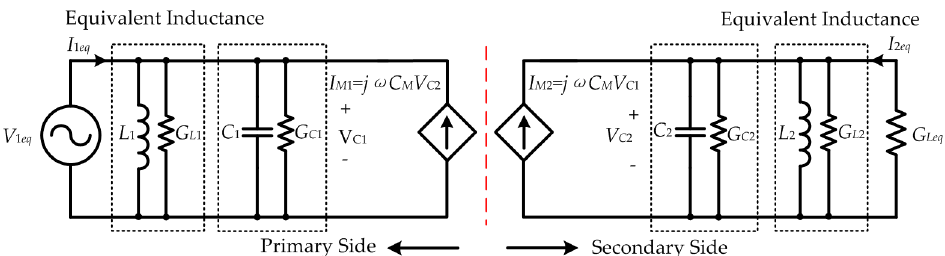
Figure 10. Equivalent circuit topology of a CPT system considering power losses of components.